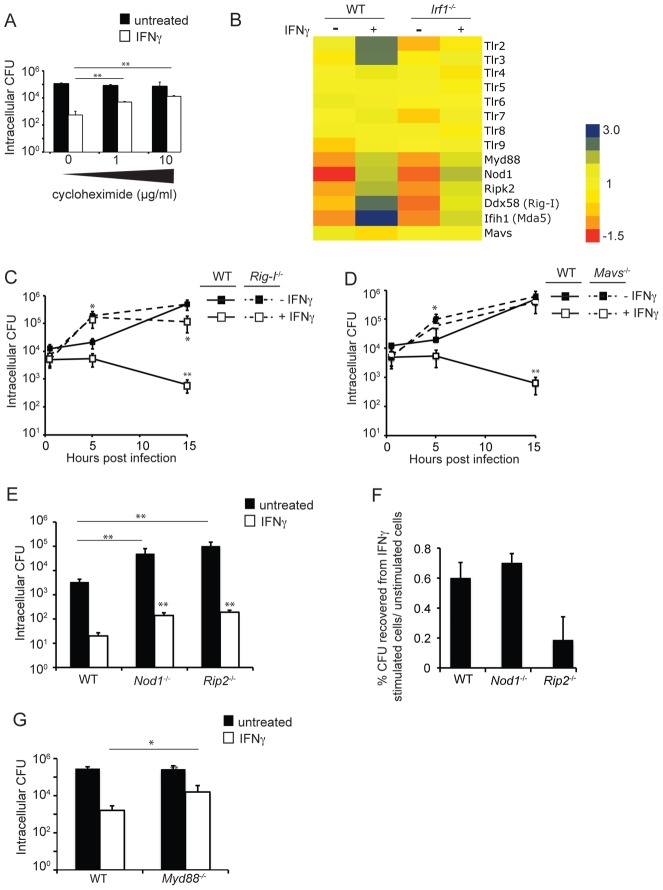
RIG-I and its downstream signaling adaptor MAVS are critical for IFNγ-mediated growth restriction of S. flexneri.(A) Host protein synthesis is important for IFNγ-mediated S. flexneri growth restriction. MEFs were stimulated with IFNγ for 24 hours or left unstimulated prior to infection. One hour prior to infection, cycloheximide was added at indicated concentrations. Intracellular CFU was determined at 15 hpi. S. flexneri invasion into host cells was equivalent under all conditions (not shown). (B) Heat map of intensity signals for selected genes under indicated conditions. Gene colors correspond to log2-transformed signal intensities from normalized expression data, indicated by the color key. (C, D) Quantification of S. flexneri CFU in indicated MEF cells infected at an MOI of 1∶1. (E, G) Quantification of S. flexneri CFU in indicated MEF cells infected at an MOI of 1∶1 for 15 hours. Invasion was equivalent under all conditions (data not shown). (F) Normalization of S. flexneri growth inhibition by IFNγ in WT, Nod1
−/− and Rip2
−/− MEFs. CFU recovered from IFNγ-treated cells for each cell line were normalized against CFU recovered from untreated cells. All data shown are means and standard deviations. Where appropriate, significant statistical differences are indicated as follows: ns, not significant; *, p<0.05; **,p<0.005 (Student's t test). Unless indicated otherwise, noted statistical differences are between unstimulated and IFNγ-stimulated cells for each condition.